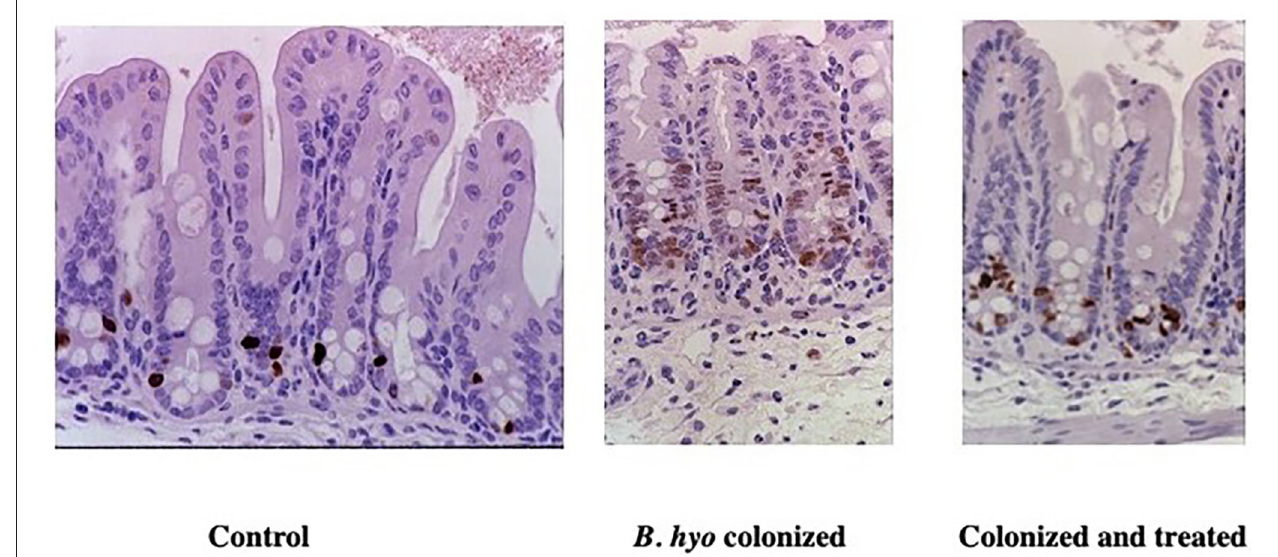
FIGURE 7 | Immunohistochemical detection of proliferating epithelial cells in mice treated with hypoxoside. Mice were either sham treated orally with sterile drinking water (Control) or hypoxoside (Colonized and treated). The mice treated daily with either saline or hypoxoside (15mg) beginning 8 days prior to colonization with Brachyspira hyodysenteriae (B. hyo). Mice were necropsied 3 days after colonization. One h prior to necropsy, mice received an IP injection of BrDU. Proliferating epithelial cells were identified by labeling their DNA with anti-BrDU using immunohistochemistry. From: (149), with